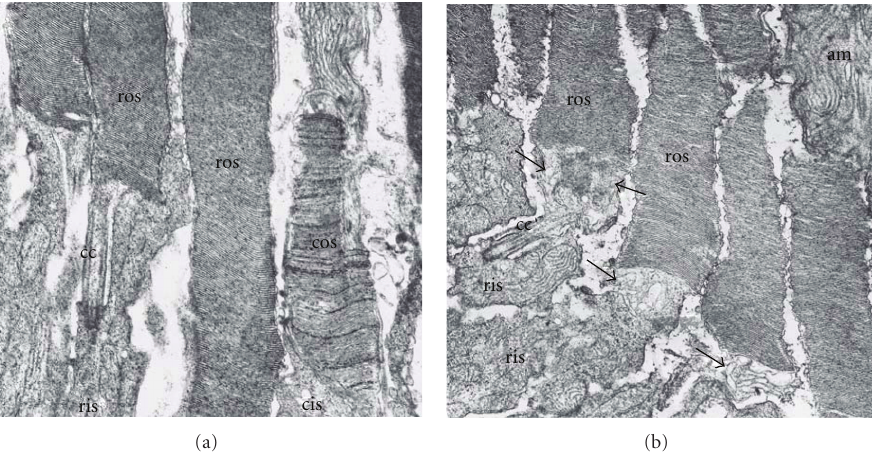
Figure 2: Electron micrographs of outer retina showing photoreceptor outer and inner segments of normal (a) Abyssinian cat and young a ff ected (b) rdAc cat. Note abnormalities at the base of the rod outer segments near the connecting cilium in (b); membranes are not formed as in the normal (a), instead there is vacuolization and degeneration (arrows) of membranes in the a ff ected retina. Am: apical microvilli of the retinal pigment epithelium, ros: rod outer segments, ris: rod inner segments, cos: cone outer segments, cis: cone inner segments, cc: connecting cilium of the photoreceptor. Original magnification: × 19152. Reproduced with permission from